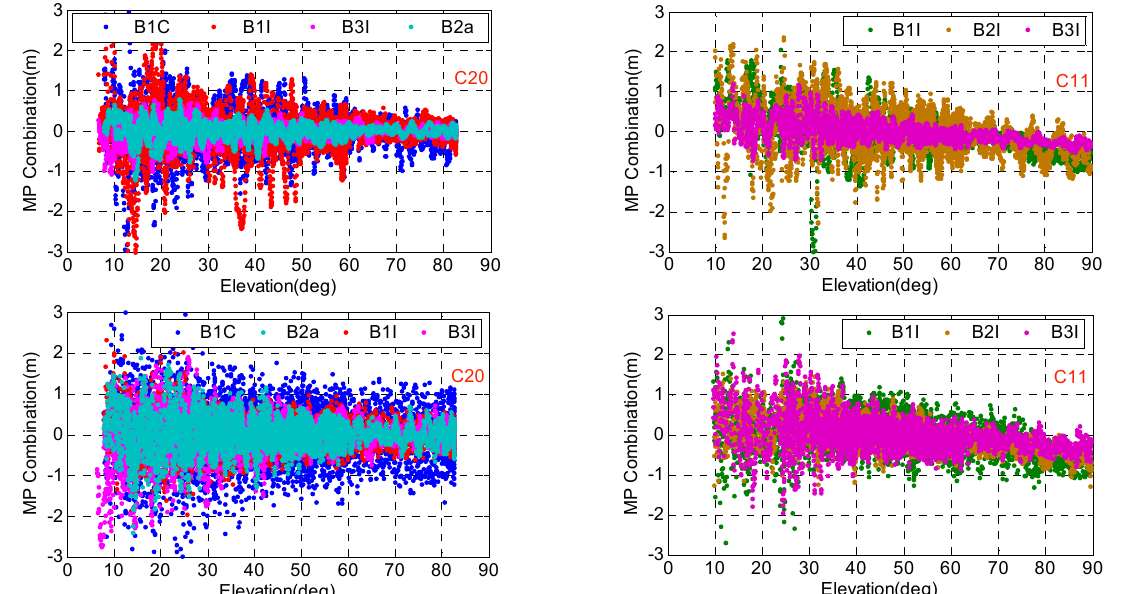
Figure 4. Multipath (MP) combinations against elevation for BDS-3 C20 and BDS-2 C11 with the iGMAS ( top panels ) and M300Pro ( bottom panels ) receiver.